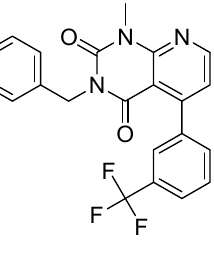
Figure 10. PubChem listed compound as analogue of the hit